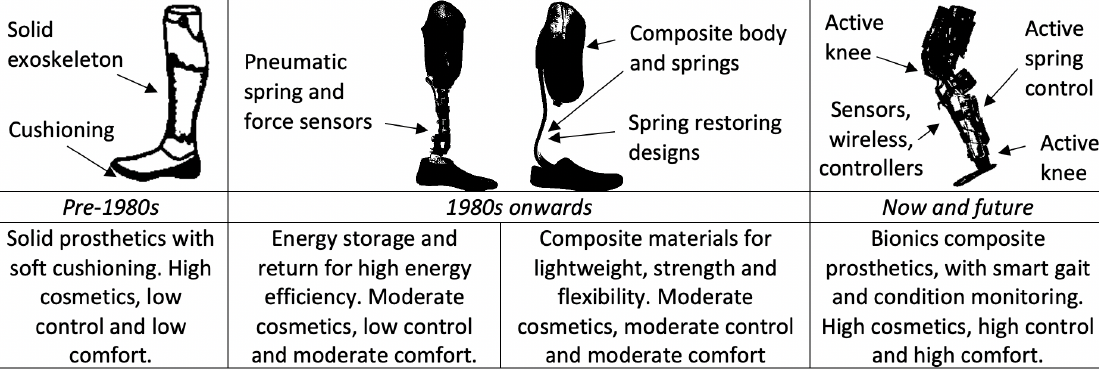
Figure 1. Brief summary of the evolution of lower limb prosthetics through the